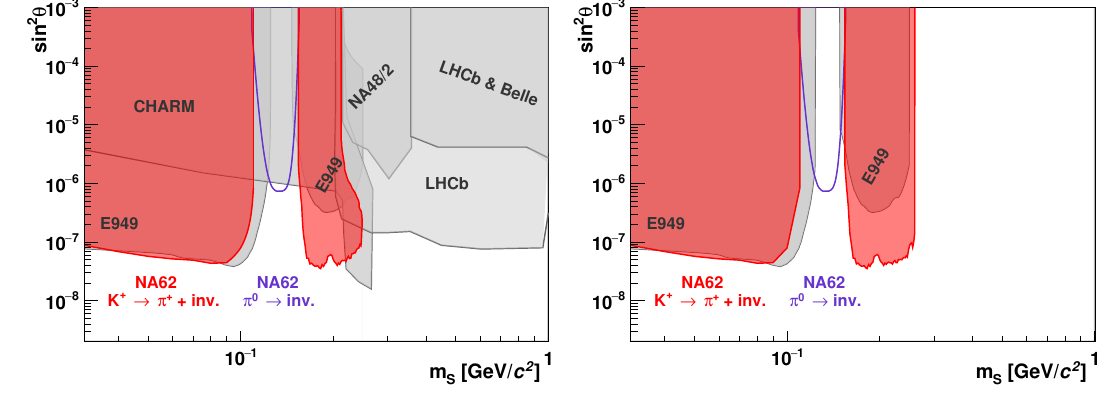
Figure 5 . Excluded regions of the parameter space ( m S , sin 2 θ ) for a dark scalar, S , of the BC4 model [1] decaying only (left) to visible SM particles as in the BC4 model and (right) invisibly. The exclusion bound from the present search for the decay K + → π + S is labelled as “ K + → π + + inv.” and is shaded in red. In the π 0 mass region the independent NA62 search for π 0 → invisible decays [25] provides constraints, shown in purple. Other bounds, shown in grey, are derived